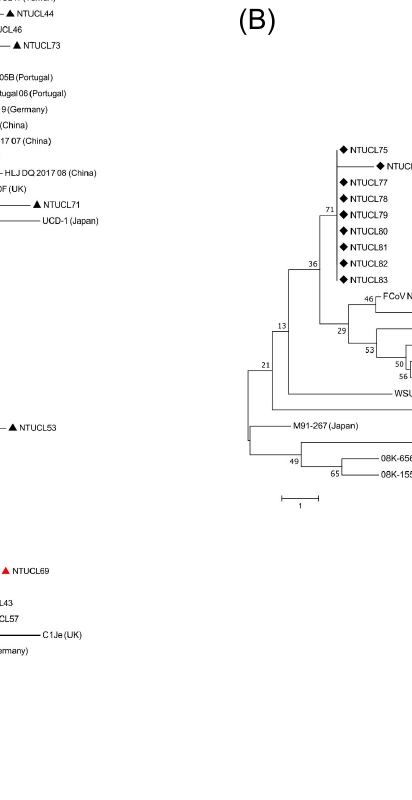
Figure 4. Phylogenetic analyses of FCoV isolates identified in effusion samples. ( A ) Phylogenetic tree of type I sequences. The triangle indicates the sequences generated in this study, the black triangle group ( ▲ ) had type I strains only, and the red triangle group ( ▲ ) had coinfected strains. ( B ) Phylogenetic tree of type II sequences. Diamonds ( ◆ ) indicate the type II sequences from the coinfection cases in this study. Neighbor-joining trees were constructed with 1000 bootstrap repli-